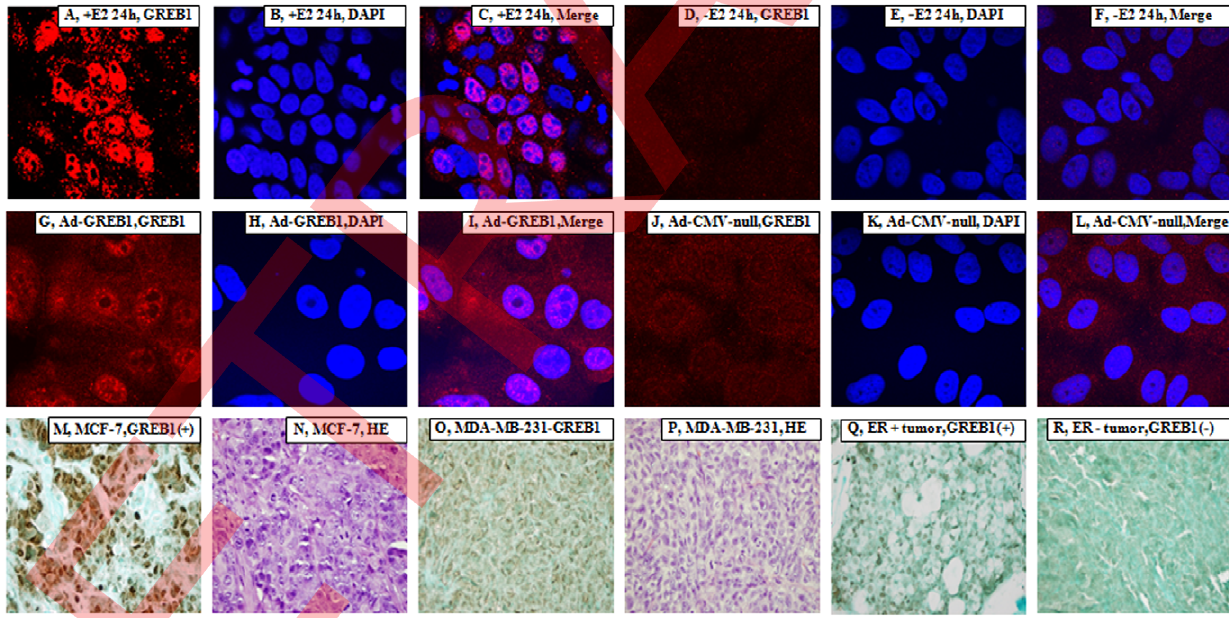
Figure 3. GREB1 is localized in the nucleus in ER-positive breast cancer cell line and breast cancer tissues. Subcellular localization of GREB1 in breast cancer cells was determined by immunofluorescent microscopy and immunohistochemical staining (IHC). A to C, E2-deprived MCF-7 cells were stimulated with E2 for 24 h and then stained for GREB1 in red (Alexa Fluor 555, A) and nucleus in blue (DAPI, B), and C gave the merged picture. GREB1 is almost exclusively localized in the nucleus. D to F showed staining of negative control lacking primary GREB1 antibody. The nuclear localization of GREB1 was further confirmed by introducing exogenous GREB1 into MCF-7 cells. GREB1 was stained in red in Figure 3G, nucleus was stained in blue in Figure 3H, the merged image was shown as Figure 3I. Figure 3J to 3L showed the staining of negative control. IHC staining showed that ER-positive MCF-7 cells (Figure 3M) and ER-positive breast cancer tissues (Figure 3Q) detected GREB1 expression (brown). ER-negative breast cancer cell line MDA-MB-231 (Figure 3O) and ER-negative breast cancer tissues expressed undetectable levels of GREB1 (Figure 3R). HE staining was also showed for ER-positive breast cancer (Figure 3N) and ER-negative breast cancer (Figure 3P).